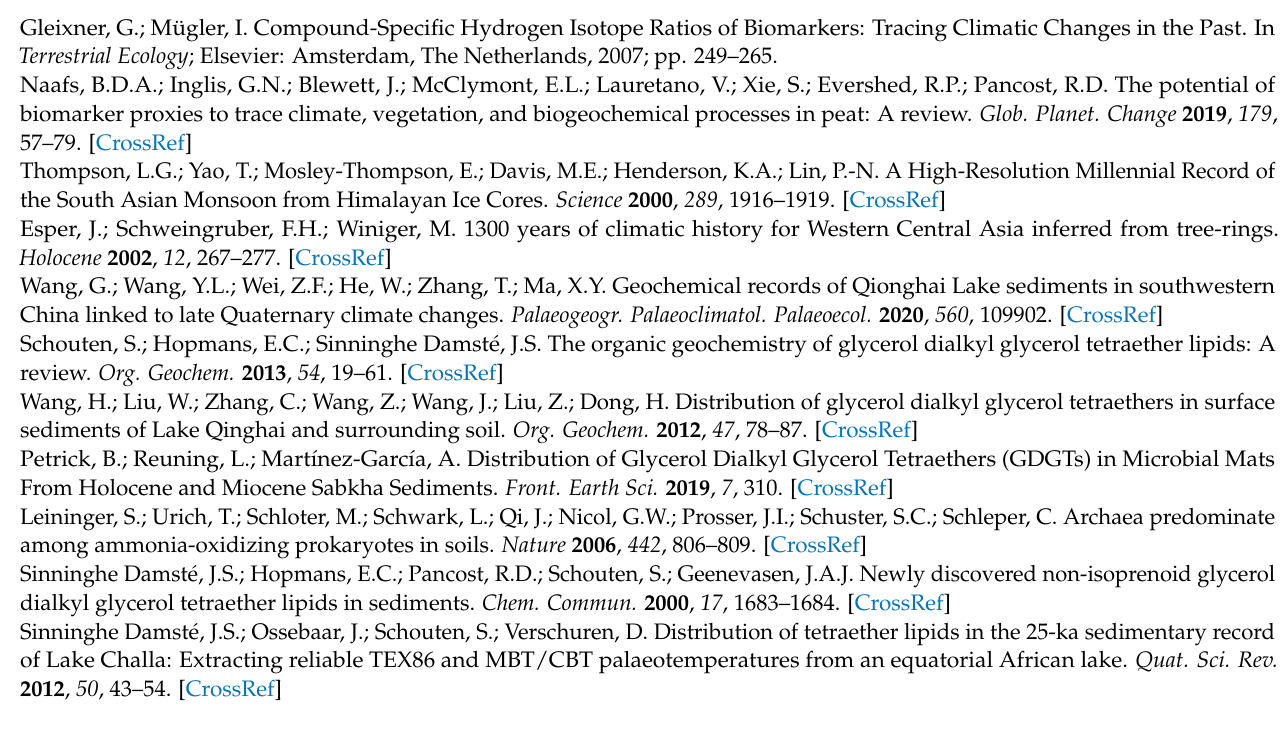
Table S4: The concentrations of major element for the 13 surface